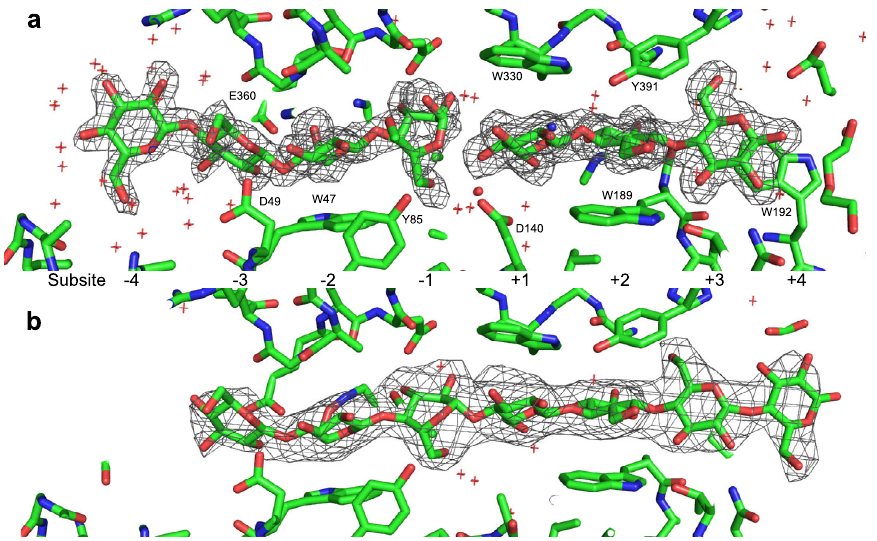
Fig. 4 Structures of oligosaccharide binding to HmCel6A. a Glc3 oligomers bind to wild-type enzyme. b Glc6 oligomer binds to D140A mutant of HmCel6A. Electron density was calculated as omit Fo-Fc map and contoured with 3 σ .